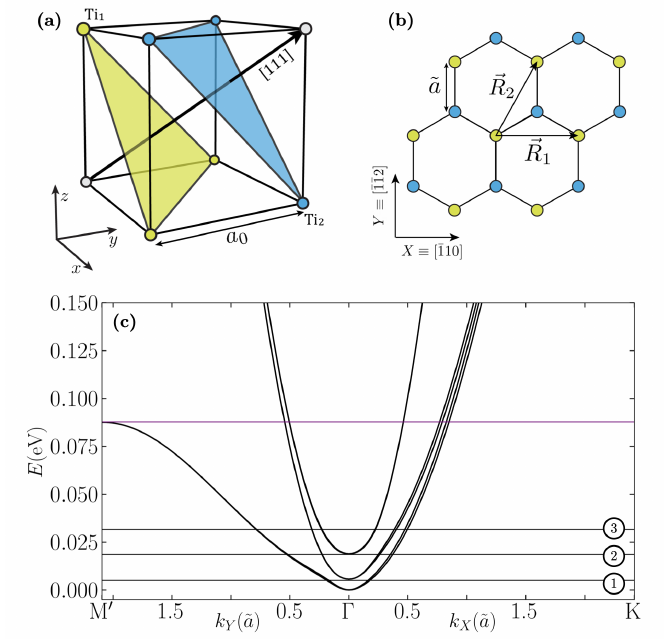
Figure 1. ( a ) Ti atoms in STO lattice, whose lattice constant is a 0 = 0.3905 nm. The blue and yellow dots represent atoms belonging to two non-equivalent planes. ( b ) Projection of the two non-equivalent planes of Ti over the (111) plane with our choice of primitive vectors (cid:126) R 1 and (cid:126) R 2 and ˜ a = ( c ) Band structure along two different directions in the Brillouin zone. The purple benchmark line corresponds to a Lifshitz transition (see Appendix